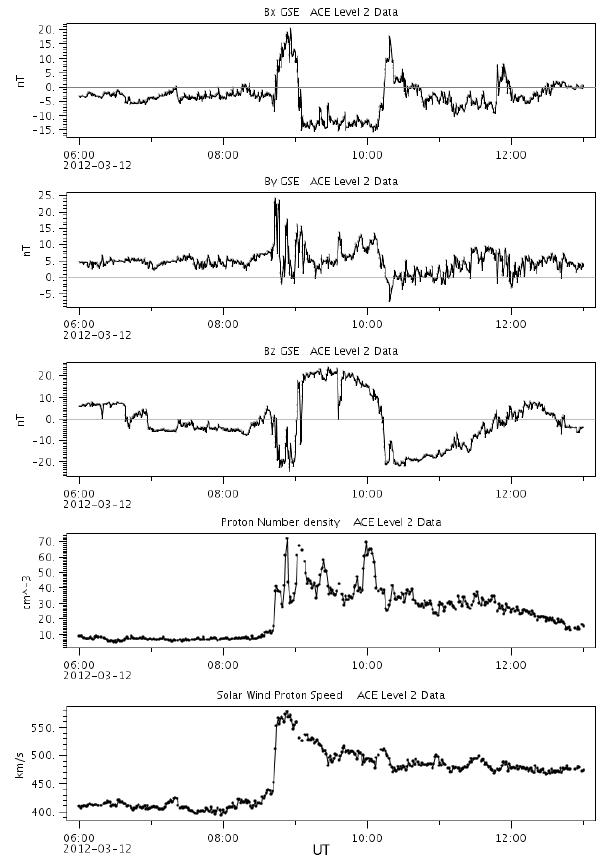
Figure 2. Solar wind variations during 06:00–13:00UT on 12 March 2012 observed by the ACE spacecraft. IMF- B x , B y , B z components, density, and speed are shown from the top to bottom panels, respectively.